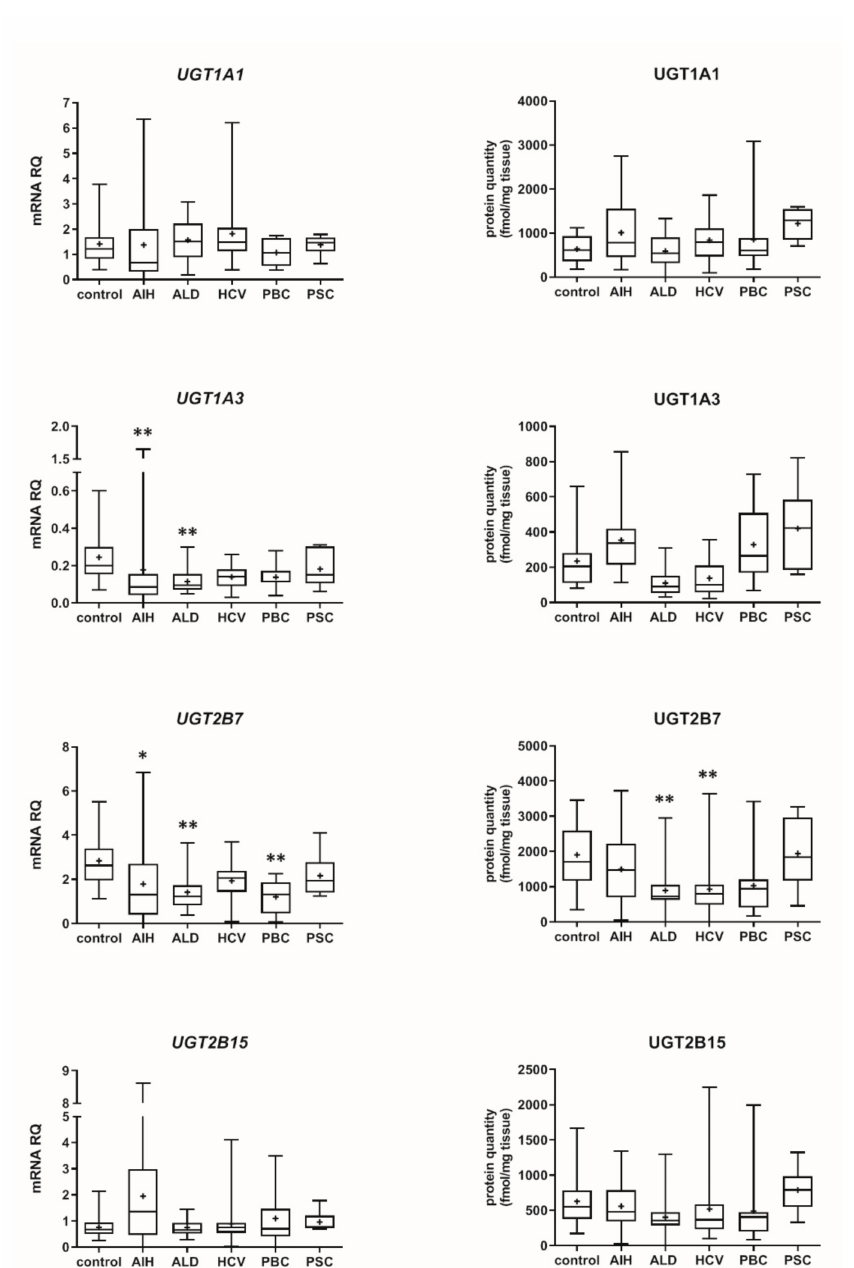
Figure 5. Gene expression ( left ) and protein abundance ( right ) of UGTs in hepatic tissues from hepatitis C (HCV, n = 21), primary biliary cholangitis (PBC, n = 10), primary sclerosing cholangitis (PSC, n = 6), alcoholic liver disease (ALD, n = 20) and autoimmune hepatitis (AIH, n = 20) patients and the controls ( n = 20). The data are represented as box-plots of the median (horizontal line), 75th (top of box), and 25th (bottom of box) quartiles, the smallest and largest values (whiskers) and mean (+) are shown. mRNA levels of the analyzed genes were expressed as relative amounts to the mean of five housekeeping genes (GAPDH, HMBS, PPIA, RPLP0, RPS9). Statistically significant differences: * p < 0.05, ** p < 0.01 (Kruskal–Wallis test post hoc Dunn’s test with Bonferroni correction) in comparison to the